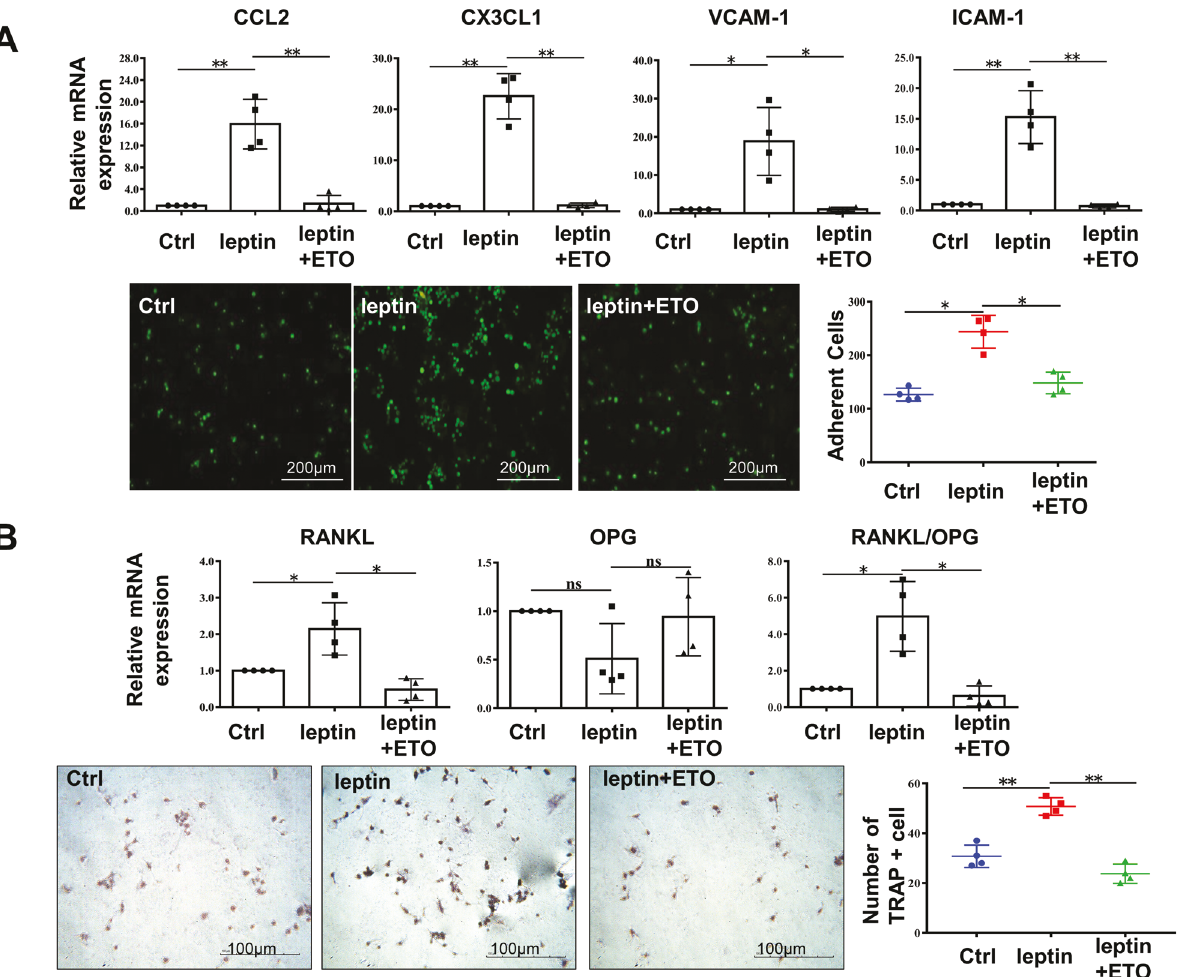
Fig. 6 Leptin-upregulated FAO favored FLS interactions with other effector cells of RA. RA-FLS was stimulated with leptin in the prsence or absence of ETO for 24 h. A Real-time PCR was performed to compare the expression of CCL2, CX3CL1, VCAM-1, ICAM-1 ( n = 4). Comparison of THP-1 monocyte adhesion to RA-FLS was detected and images were captured with a fl uorescence microscope (scale bar = 200 μ m, n = 4). B RANKL, OPG expression and RANKL/OPG ration were assessed with real – time PCR analysis ( n = 4). TRAP-positive multinucleate cells were identi fi ed and counted after THP-1 monocyte was stimulated with supernatant from RA-FLS exposed to corresponding treatment. TRAP- positive cells were captured under a light microscope (scale bar = 100 μ m, n = 4). Data are means ± SEM of three independent experiments, statistical signi fi cance was determined as ** P < 0.01, * P < 0.05, ns means no signi fi cance compared with